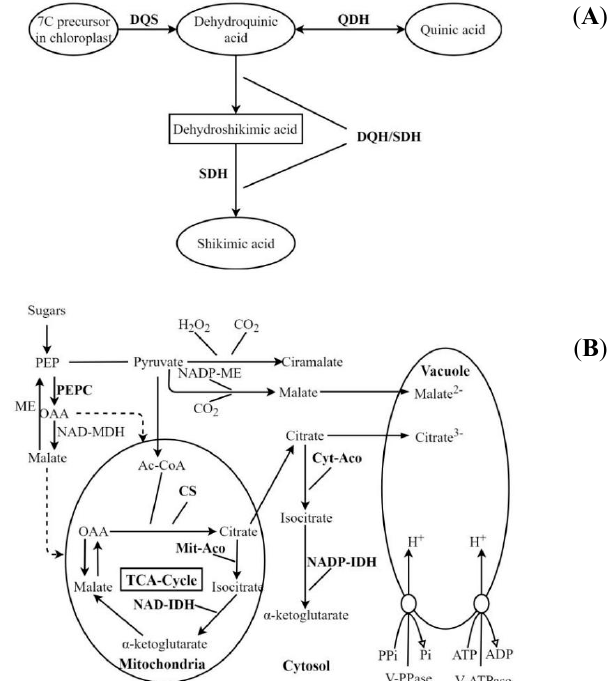
Figure 1. Schematic representation of the quinic acid ( A ) and citric acid ( B ) metabolic pathways in